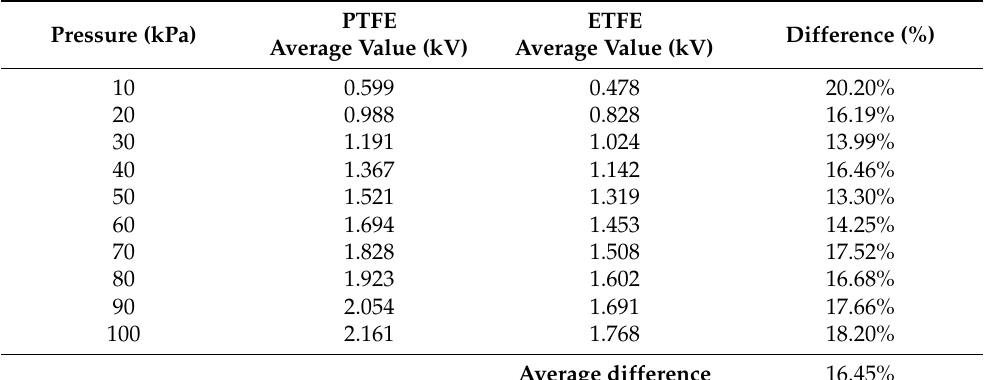
Table 5. CEV average values difference (%) between PTFE and ETFE samples at the different analyzed pressures.